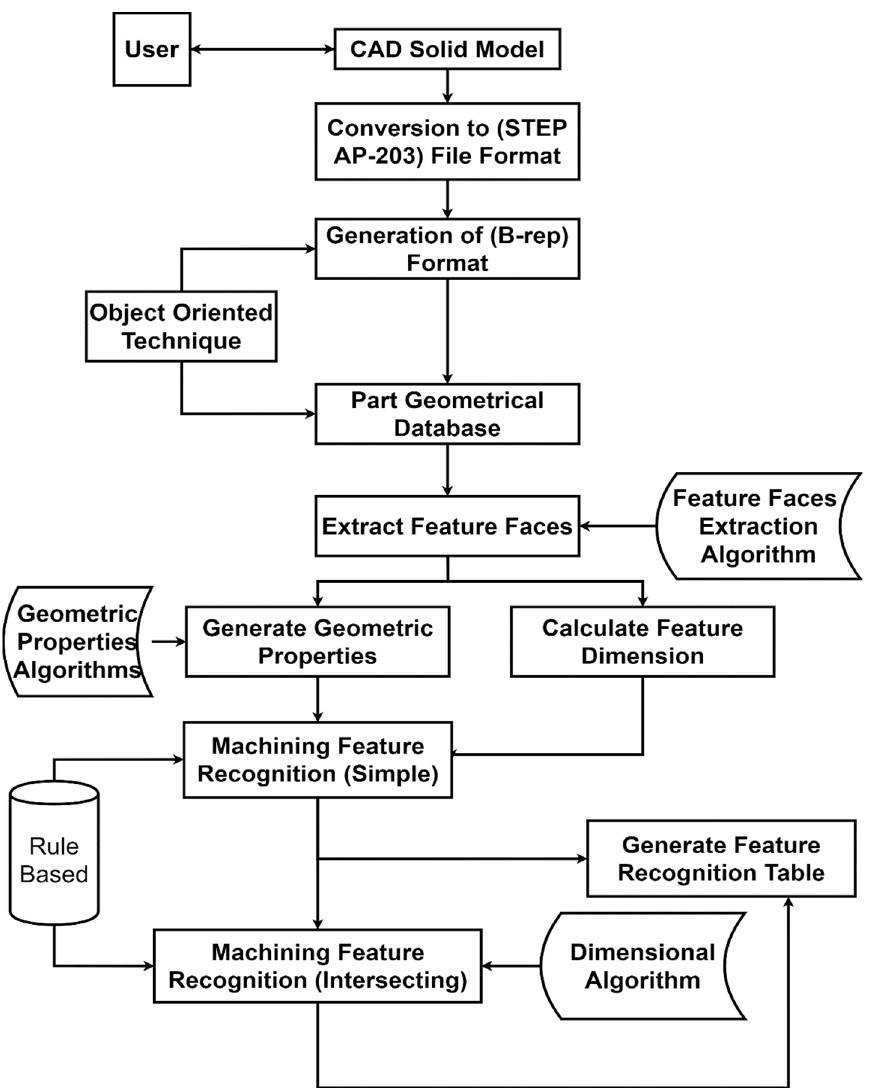
Figure 3. Data extraction and feature recognition process [27].